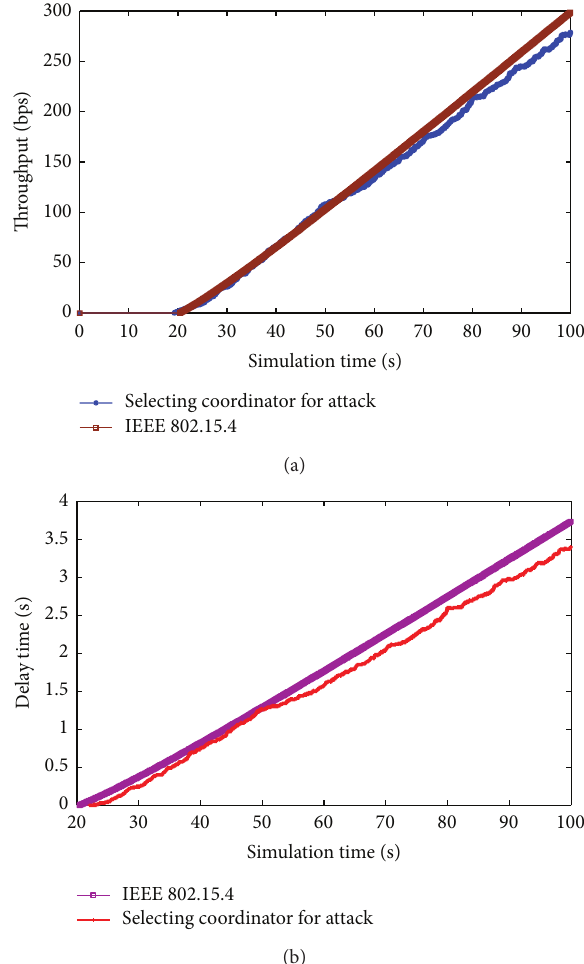
Algorithm 2. Get CoordinatorResourceState (CID):